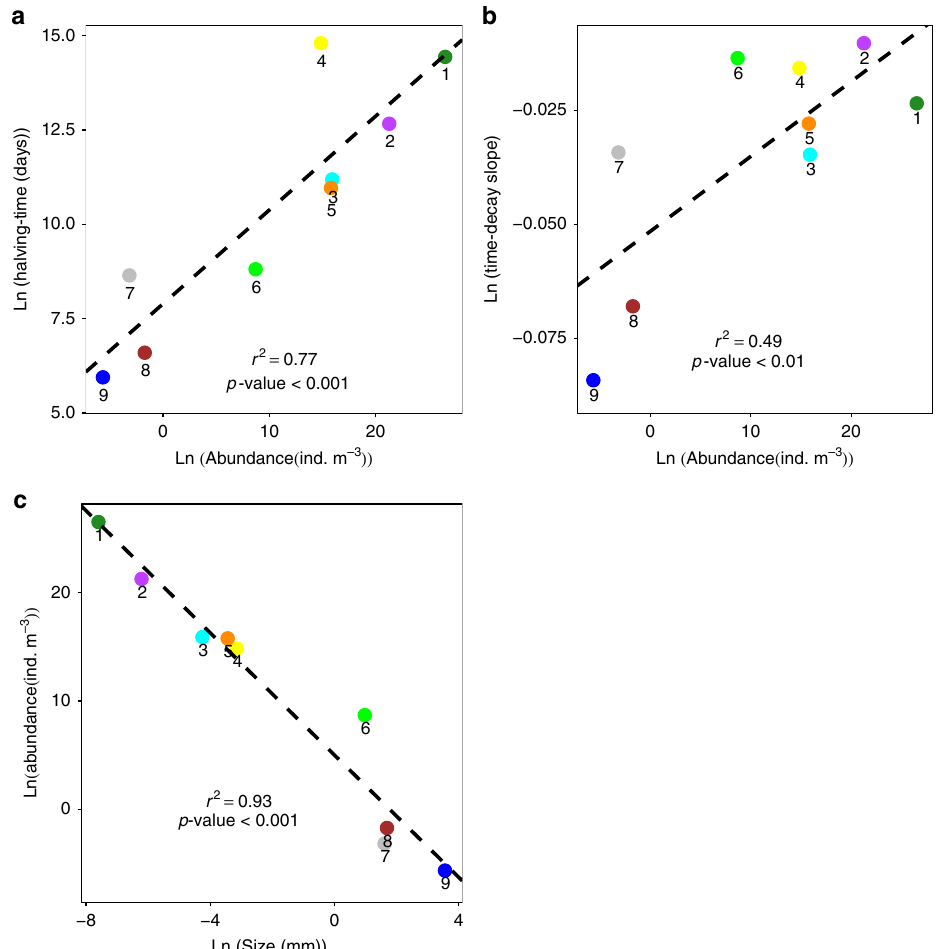
Fig. 3 Correlations between halving-time and time-decay slopes with local abundance. a Correlation between the logarithms of halving-time ( y ) and local abundance ( x ) in main biological groups; linear regression equation y = 7.892 + 0.248 x , n = 9, r 2 = 0.766, p -value < 0.001. b Correlation between the logarithms of the time-decay slope ( y ) and local abundance ( x ) in main biological groups; linear regression equation y = − 0.051+ 0.001 x , n = 9, r 2 = 0.487, p -value < 0.01. c Correlation between the logarithms of local abundance ( y ) and body size ( x ) in main biological groups; linear regression equation y = 5.002 − 2.820 x , n = 9, r 2 = 0.930, p -value < 0.001. Main biological groups: prokaryotes (1); microbial eukaryotes all (2); coccolithophores 0 – 160 m (3); dino fl agellates 0 – 160 m (4); diatoms 0 – 160 m (5); mesozooplankton surface (6); gelatinous zooplankton (7); macrozooplankton (8); myctophids (9). Ln = Napierian logarithm. P -value is calculated at 95% of con fi dence interval in non-parametric bootstrap